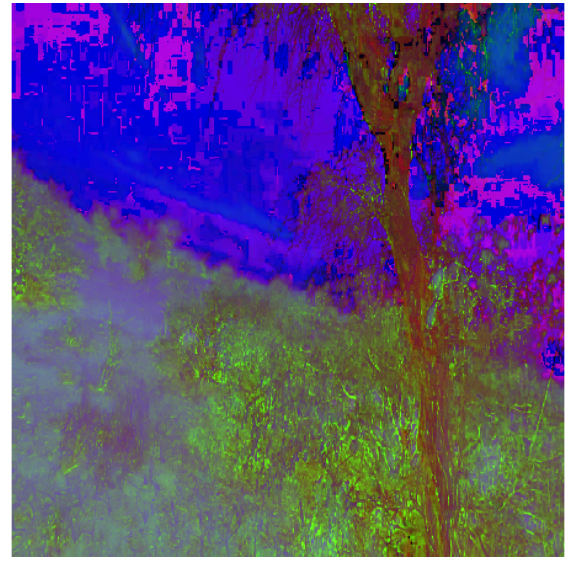
Figure 6. Sample image in the HSV color